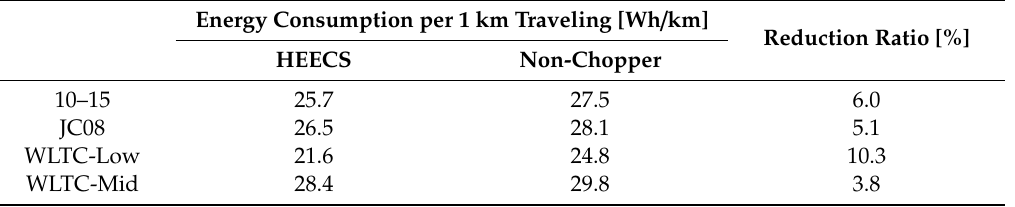
Table 4. Simulation results of energy consumption in test